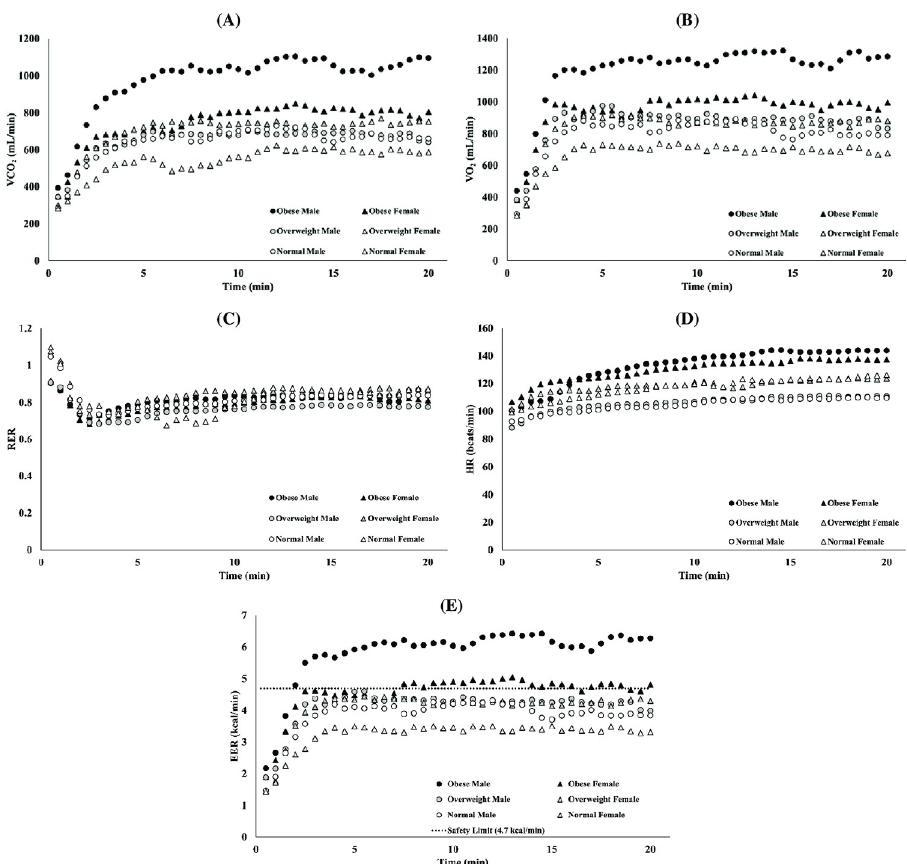
Fig 2. Time-dependent metabolic parameters across testing period. Subjects were grouped into their corresponding BMI classifications and gender: black circle is obese male, black triangle is obese female, grey circle is overweight male, grey triangle is overweight female, white circle is normal male, and white triangle is normal female. An average value for five metabolic dependent variables was taken for each BMI-gender group over the testing period. The figure represents the relationship between elapsed time and average: (A) VCO2; (B) VO2; (C) RER; (D) HR; and (E) EER, with the dotted line representing the safety limit (4.7 kcal/min).